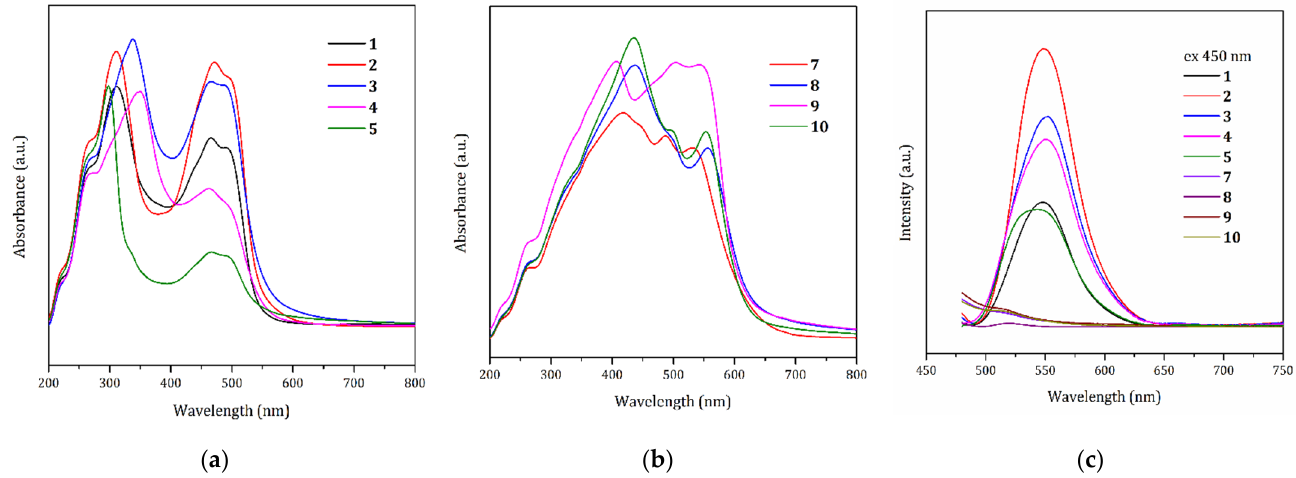
Figure 19. The solid-state absorption spectra of cocrystals 1 – 5 ( a ) and salts 7 – 10 ( b ). Emission spectra of compounds 1 – 5 and 7 – 10 ( c ). Table 1. Absorption maxima for compounds 1 – 5 and 7 – 10